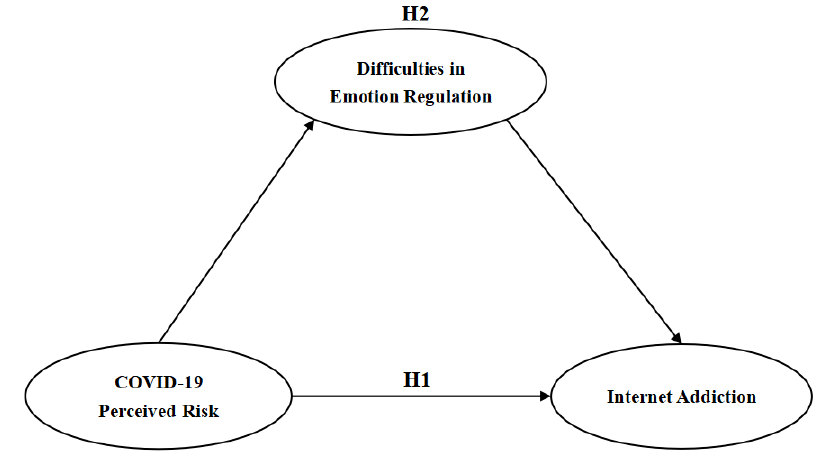
Figure 1. Hypothesis